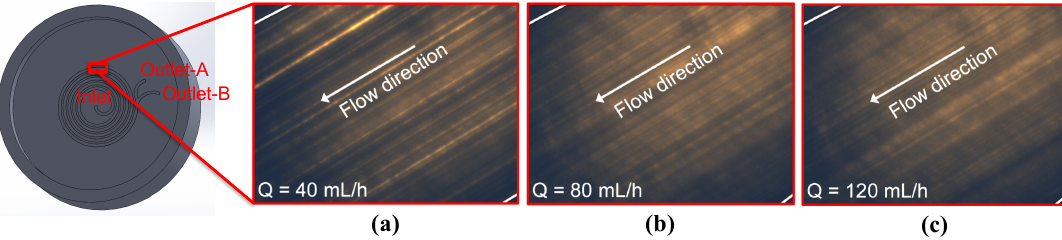
Figure 9. Experimental results for different flow rates (spiral channel with an AR 9.0, 2.0 µ m particles). Flow rate: ( a ) 40 mL/h; ( b ) 80 mL/h; ( c ) 120